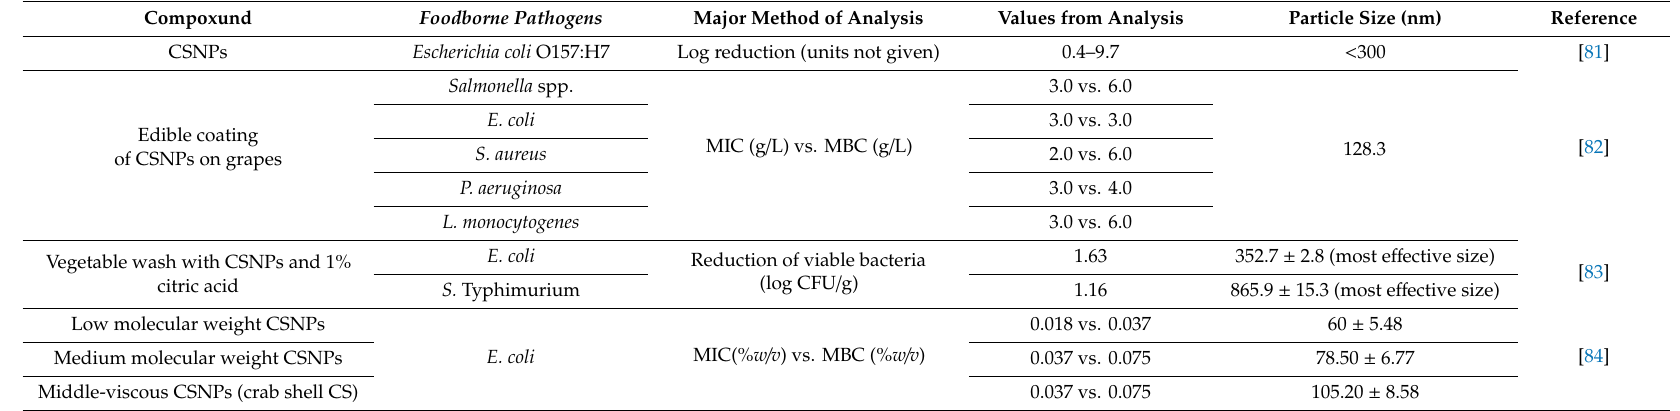
Table 2. Direct uses of chitosan nanoparticles to control foodborne pathogens (MIC: minimum inhibitory concentration; MBC: minimum bactericidal